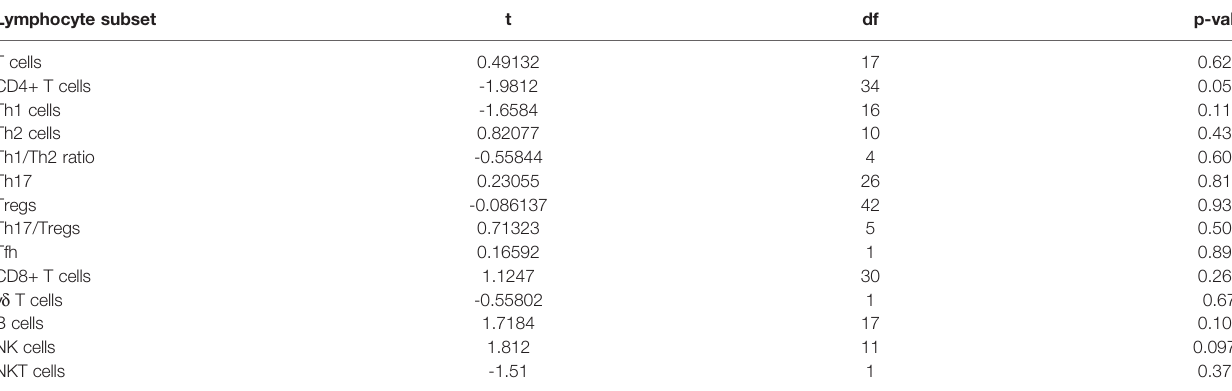
TABLE 2 | Egger ’ s tests by different lymphocyte